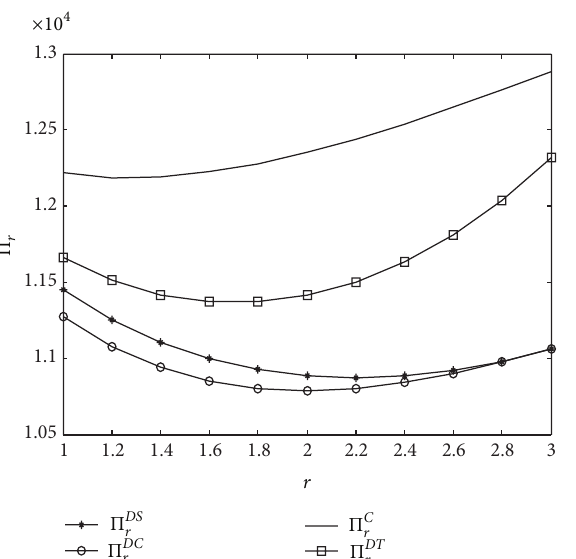
Figure 9: Impact of 𝛿 on manufacturers profits.